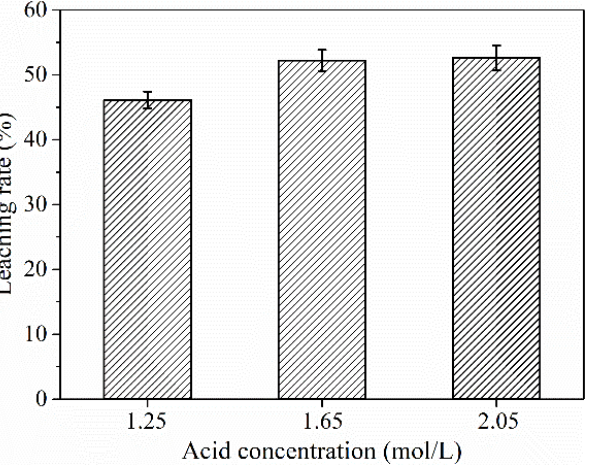
Figure 7. The effect of HCl concentration on REE leaching rate at 30 °C and S/L ratio of 1/10 for leaching 2 h.